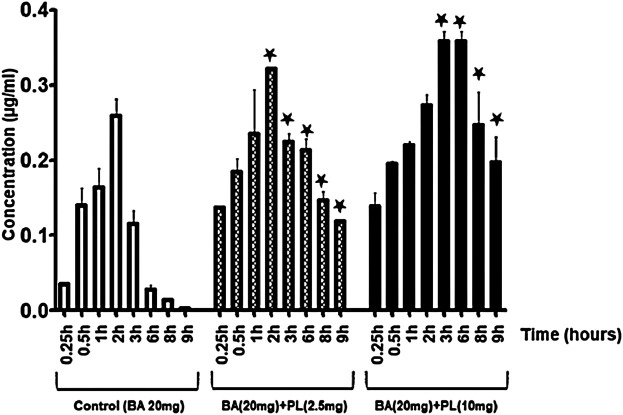

Piper longum extract (2.5 and 10 mg/kg) increases the serum concentration of β-boswellic acid in rabbits (*p < 0.05). BA-β-boswellic acid (20 mg/kg).